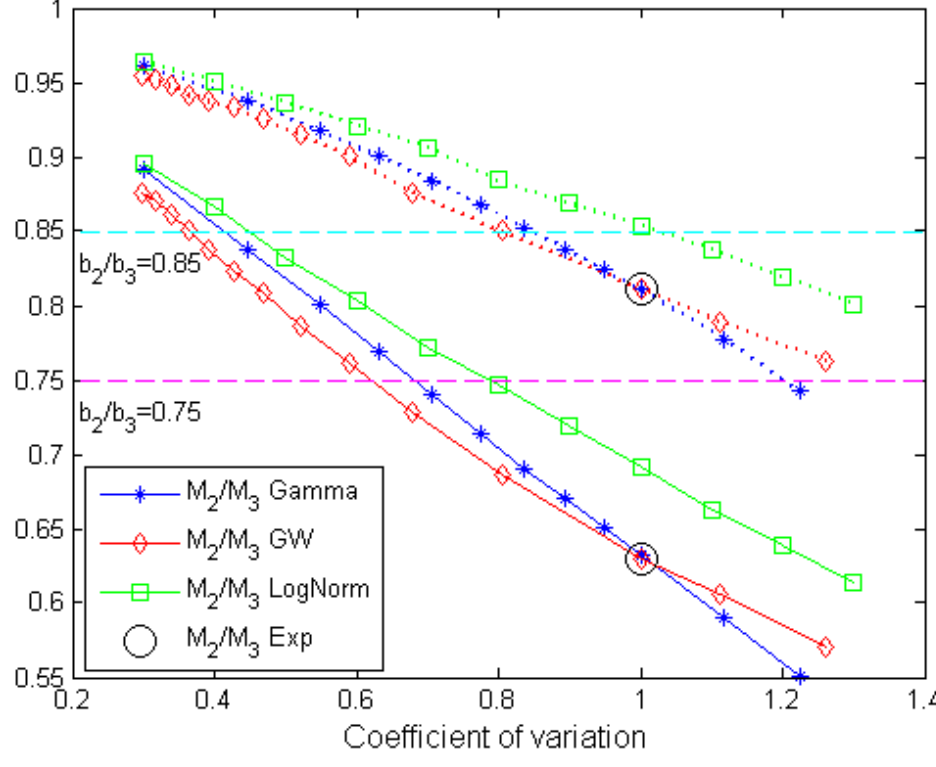
Figure 2. Comparison of “2-strategy” and ”3-strategy” for different coefficients of